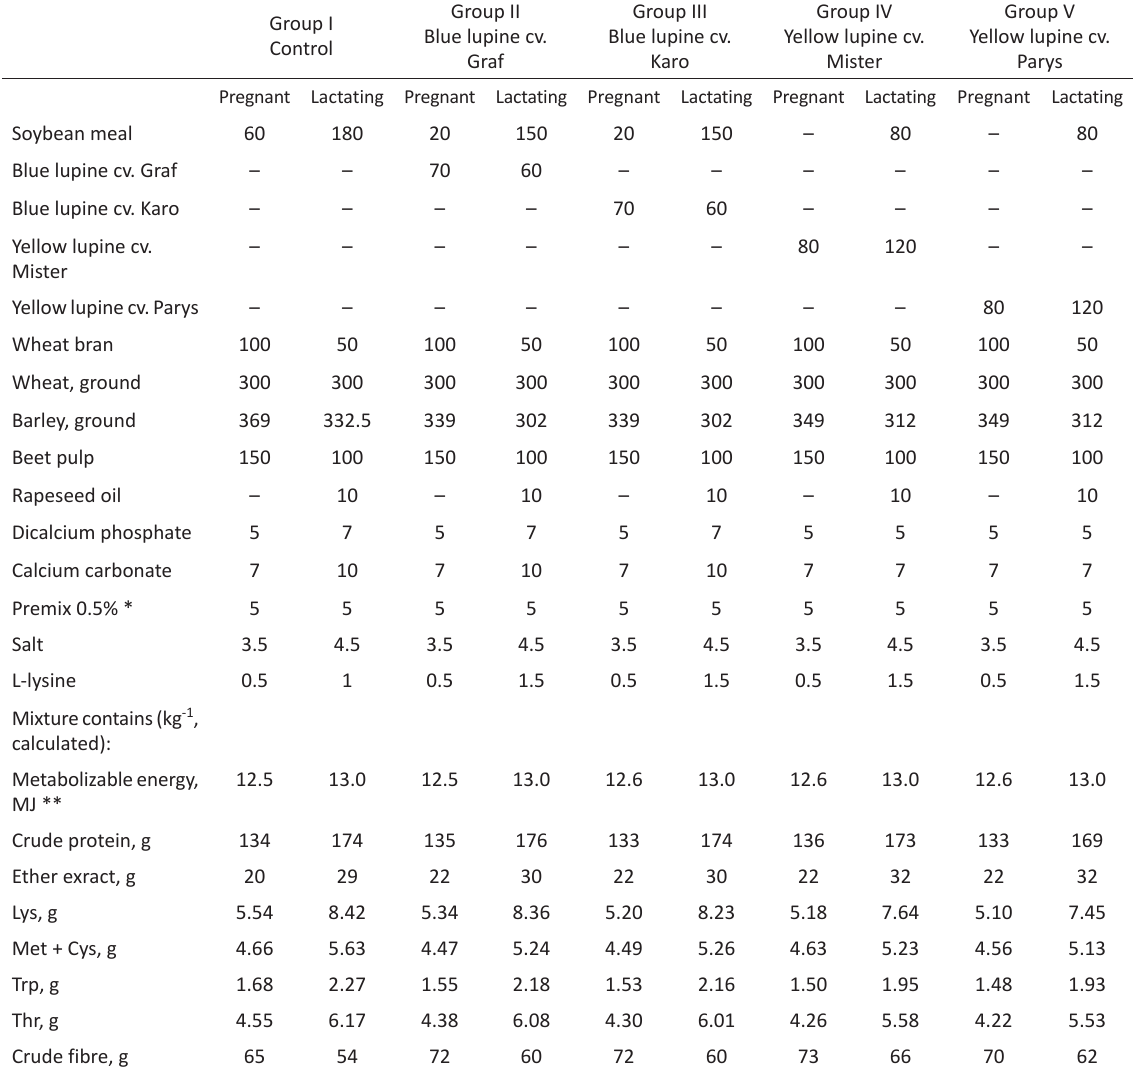
Table 1. Composition and nutrient contents of the diets for experimental sows (g kg -1 )